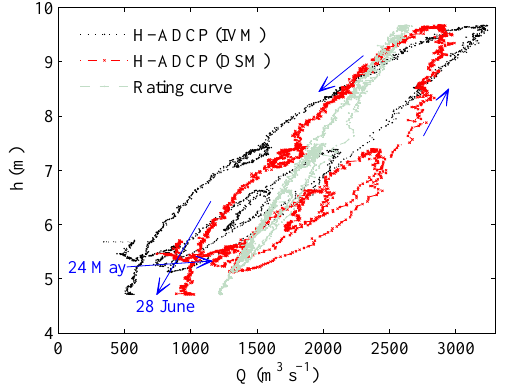
Fig. 11. Water stage and discharge estimates at Melak station, ob- tained from a rating curve (Jones’ formula) and from H-ADCP mea- surements. Water stage is with respect to the position of a pressure gauge about 9m from the deepest part of the river cross-section.